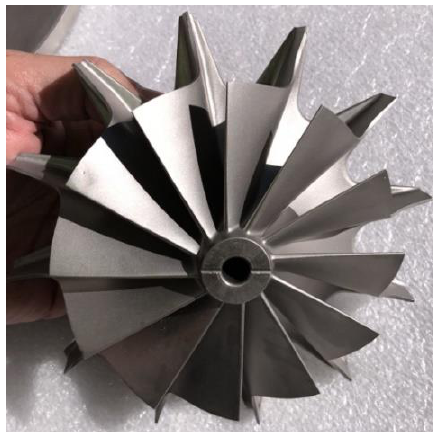
Figure 9. Turbine wheel from the T-62T engine.